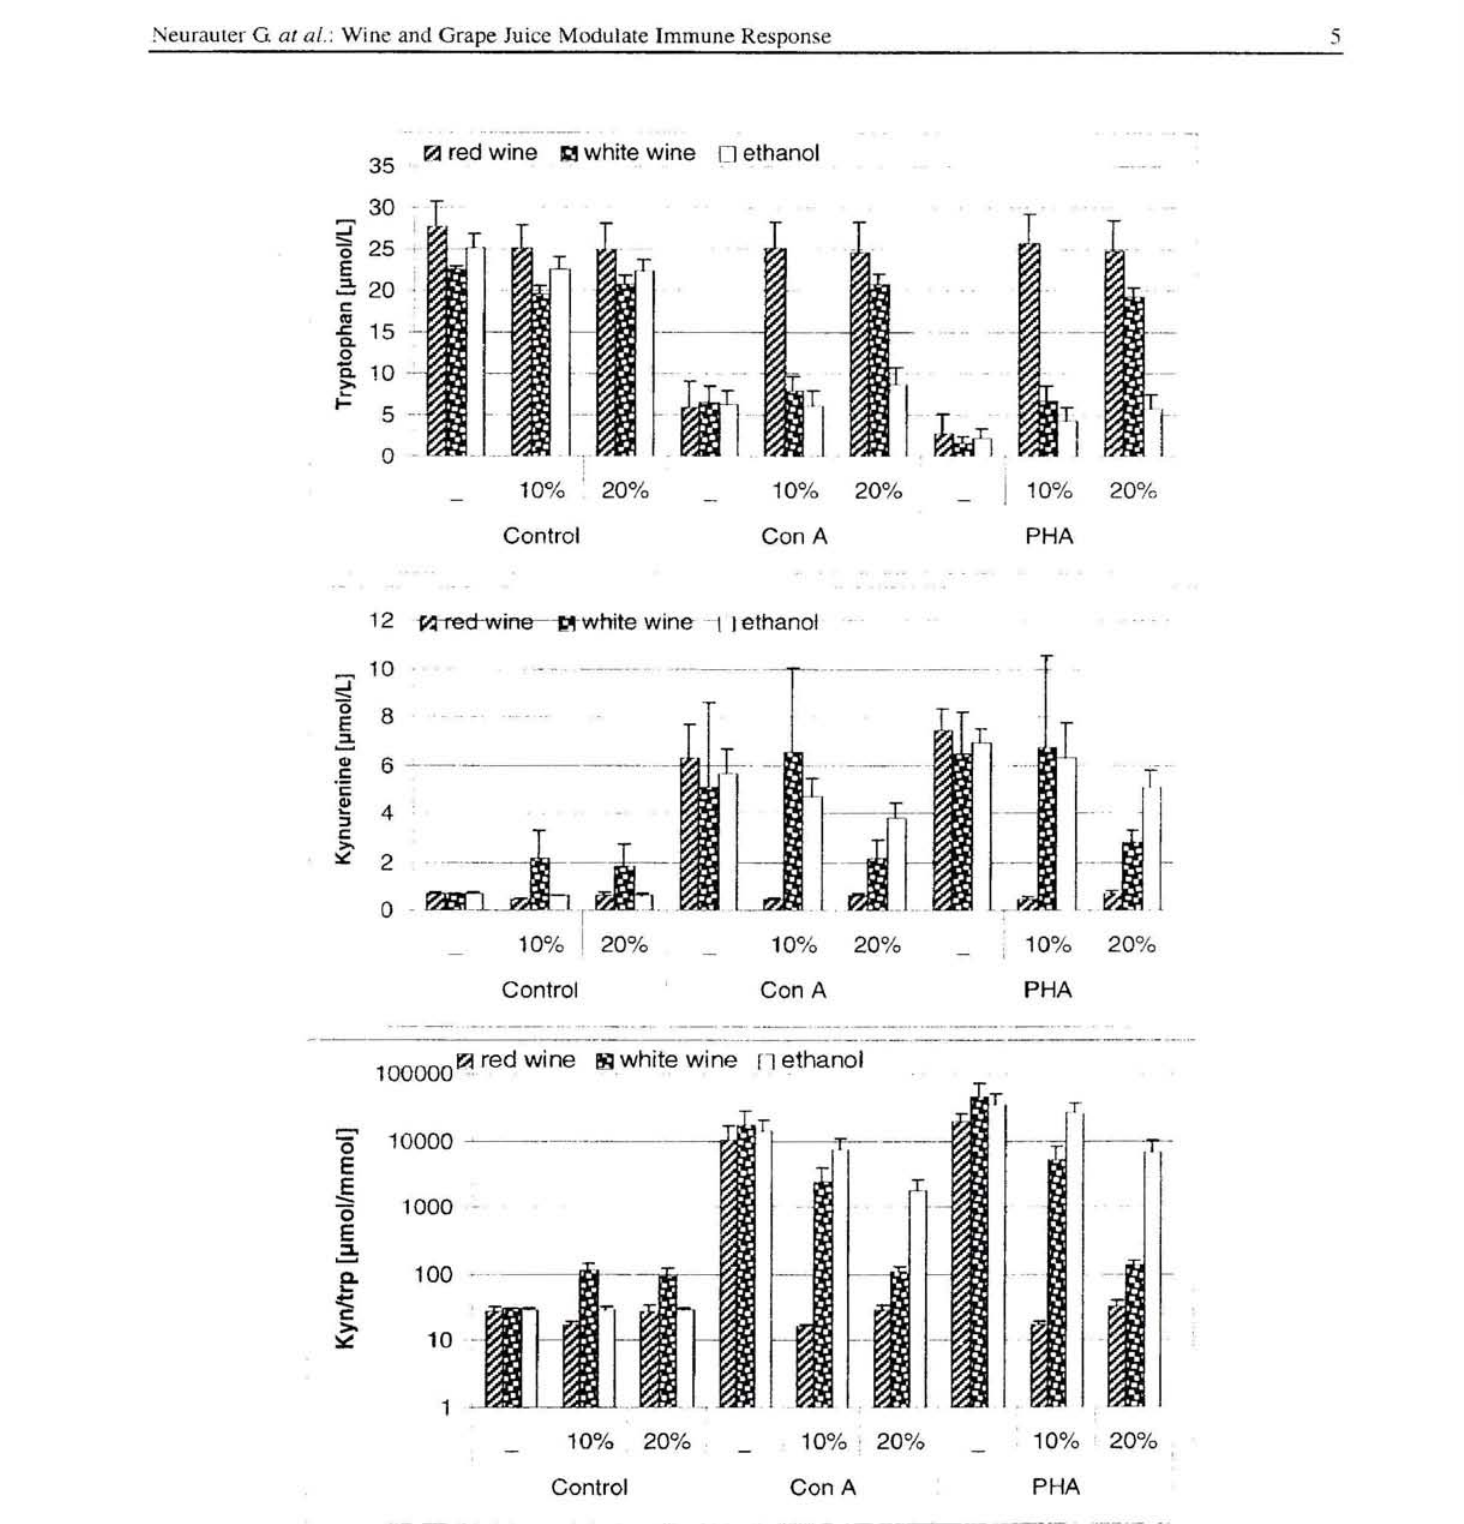
Figiire 3. Intluence of wines (RW red wine, WW white wine), and ethanol (Eth) on tryptophan dcgradalion in penpheral blood mononuclear cells induccd by mitogens concanavalin A (Con A) and phytohaemagglutinin (PHA). Tryptophan degradation is calculated as the kynurenine per tryptophan ratio (Kyn/trp) which indicales indoleamine (2,3)-dioxygenase activity; 1:10 (= 10% v/v) and 1:5 (= 20% v/v) dilutions of beverages and of 11.5 and 12.0% ethanol in RPMI (final concentrations 1.2 and 2.3 % ethanol) were tested. (columns show means + S.E.M.; *p<0.05, #p <0.01; note log-scale of kyn/trp) Pteridines/Vol. 15/No.